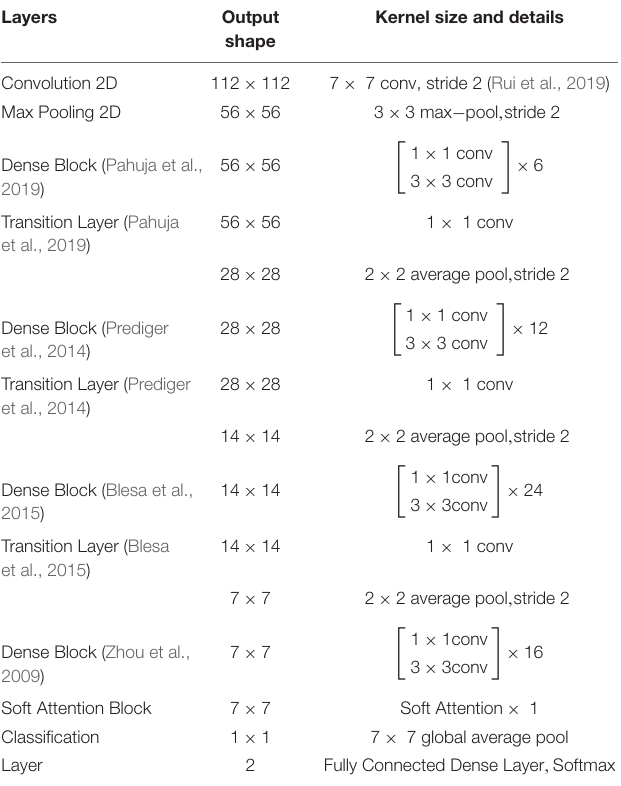
TABLE 3 | DenseNet121 architecture with Soft Attention Block for classification of PD and HC